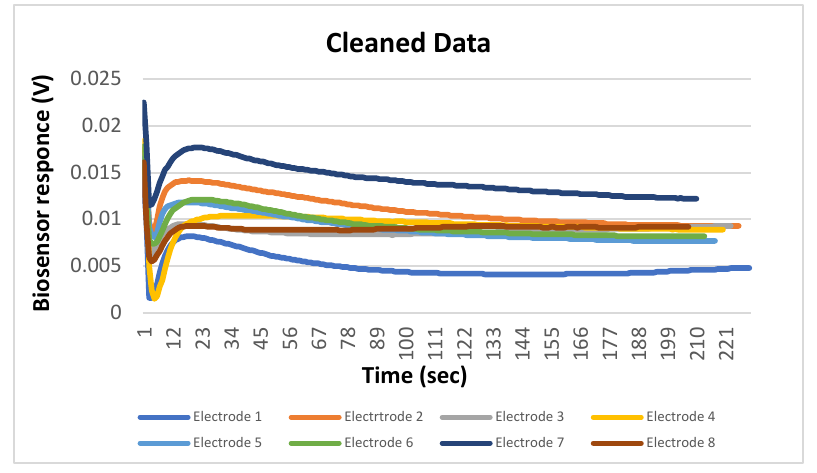
Figure 3. Visualization of the electric signal via a voltage (Volts) vs. time graph of the cleaned data.